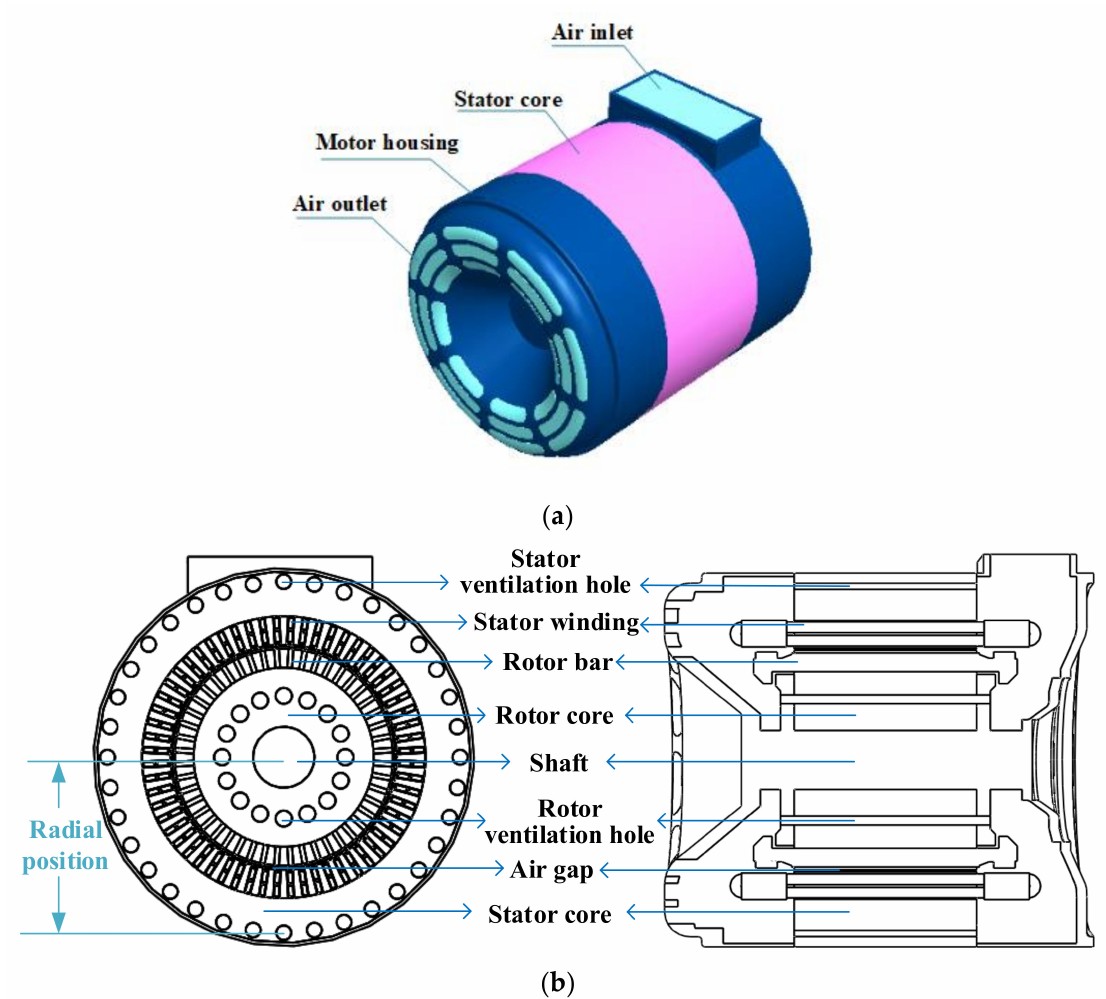
Figure 1. Structure of the induction traction motor. ( a ) Three-dimensional structure of the motor; ( b ) Motor structure in the radial and axial